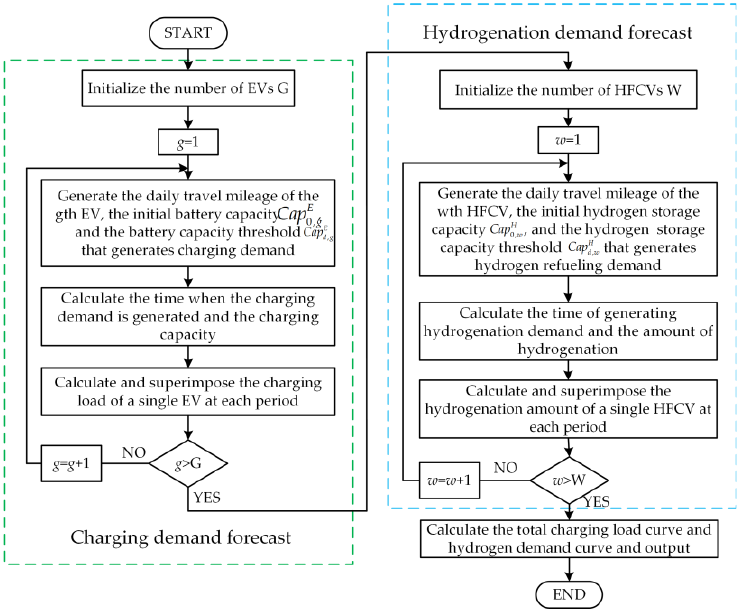
Figure 2. Charging and hydrogen demand simulation flowchart.